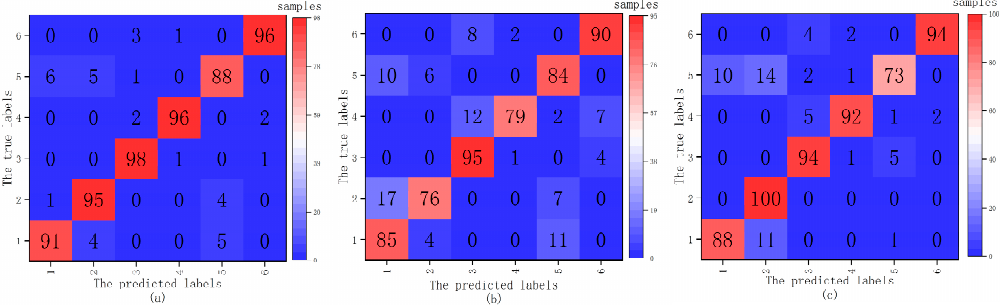
Figure 7. Confusion matrices of the three fault diagnosis models (( a ) SVM-based model, ( b ) CART-based model, ( c ) k -NN-based model). The x -axis corresponds to the predicted labels, while the y -axis represents the true labels.